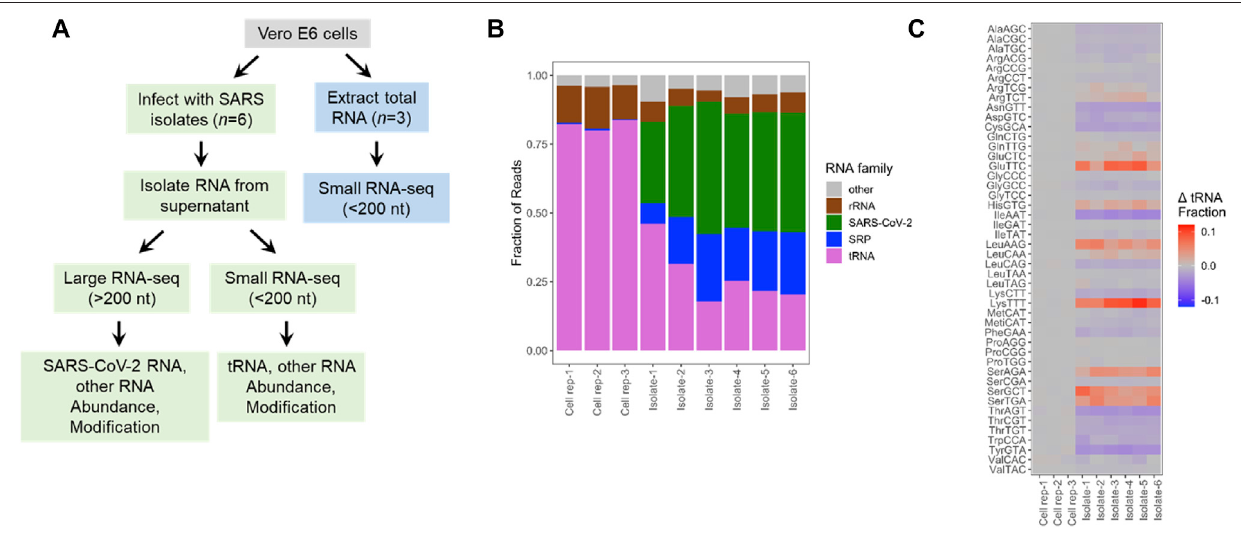
FIGURE 1 | Selective enrichment of small RNAs in SARS-CoV-2 viral preparations. (A) Experimental scheme. Vero E6 cells were either infected with SARS-CoV-2 virus isolates from infected individuals ( n = 6 biological isolates) or uninfected cultures ( n = 3 biological replicates). Total RNAwasextracted from the cells (blue boxes) or only from the cell free viral preparations (green boxes). Small RNA-seq was carried out using total RNA with and without demethylase treatment. Large RNA-seq was carriedoutwiththeRNAfractionaftertheremovalofsmallRNAsof < 200 nt,andchemicalfragmentation. (B) SmallRNA-seqresults.VerocelldataaremostlytRNA and 5S/5.8S rRNA. Aside from SARS-CoV-2 RNA, virions contain signi fi cant portions of tRNA, rRNA, and signal recognition particle (SRP) RNA. (C) Enrichment and depletion of speci fi c tRNAs in the cell free viral samples. Shown are the combined reads from all tRNA isodecoders that share the same anticodon. Heatmap shows the abundanceoftRNAsforeachanticodonsubtractedfromthemeanofcontrolcultures.SubtractionemphasizesthedifferencesamongabundanttRNAs.EnrichedtRNAs are in red, depleted tRNAs in blue. Top 3 enriched tRNAs are tRNA Lys (TTT), tRNA Glu (TTC), and tRNA Ser (GCT). Top 3 depleted tRNAs are tRNA Ile (AAT), tRNA Tyr (GTA), and tRNA Asn